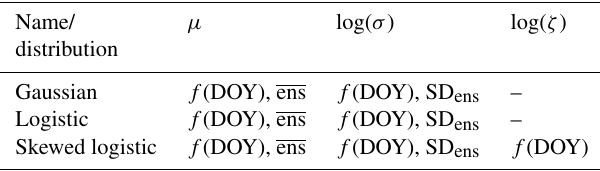
Table 1. Covariates used in the linear predictors of the distribu- tional parameters µ , σ , and ζ for all response distributions. ens and SD ens represent the ensemble mean and the standard deviations of the ensemble 2m temperature, respectively; f (DOY) represents the smooth cyclic seasonal